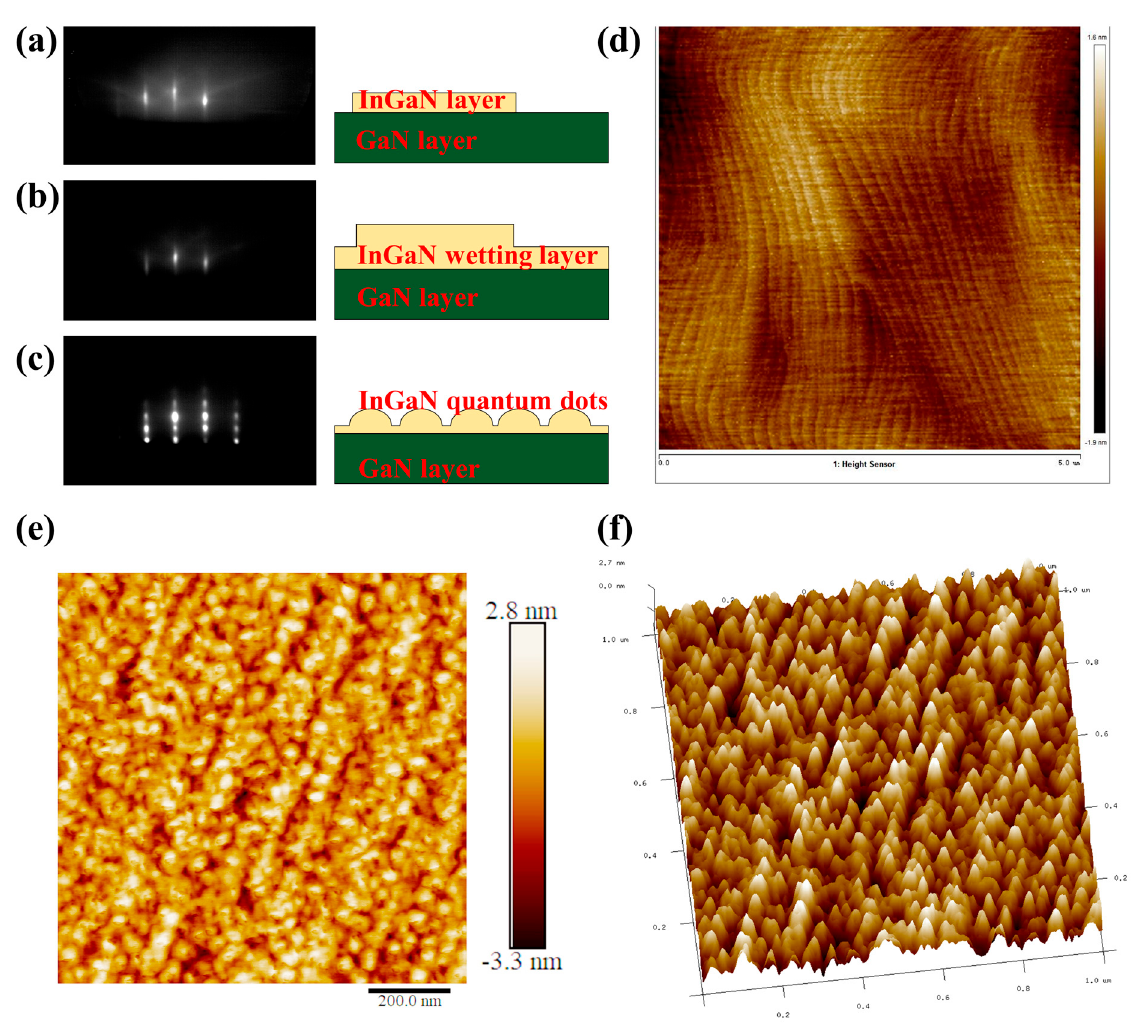
Figure 2. ( a − c ) The RHEED pa tt erns of self-assembled InGaN QDs in di ff erent growth states; ( d ) the Figure 2. ( a – c ) The RHEED patterns of self-assembled InGaN QDs in different growth states; ( d ) the AFM image of GaN layer; ( e , f ) the 2D and 3DAFM images of InGaN QDs. AFM image of GaN layer; ( e , f ) the 2D and 3DAFM images of InGaN